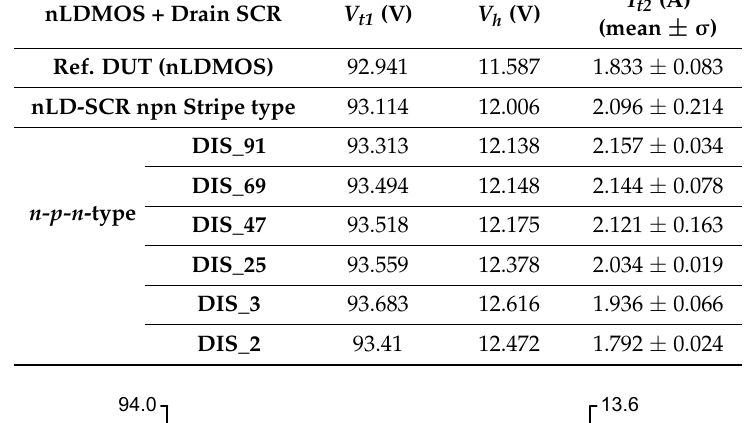
Table 1. Snapback key parameters of the nLDMOS-SCR ( n-p-n -arranged) tested samples.